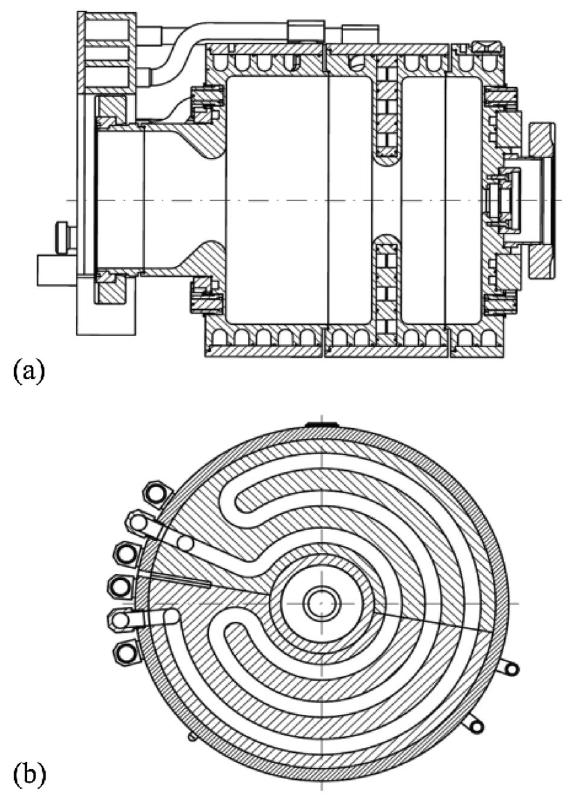
FIG. 2. (a) Transverse cross-sectional view of the gun cavity and (b) axial cross-section at the iris